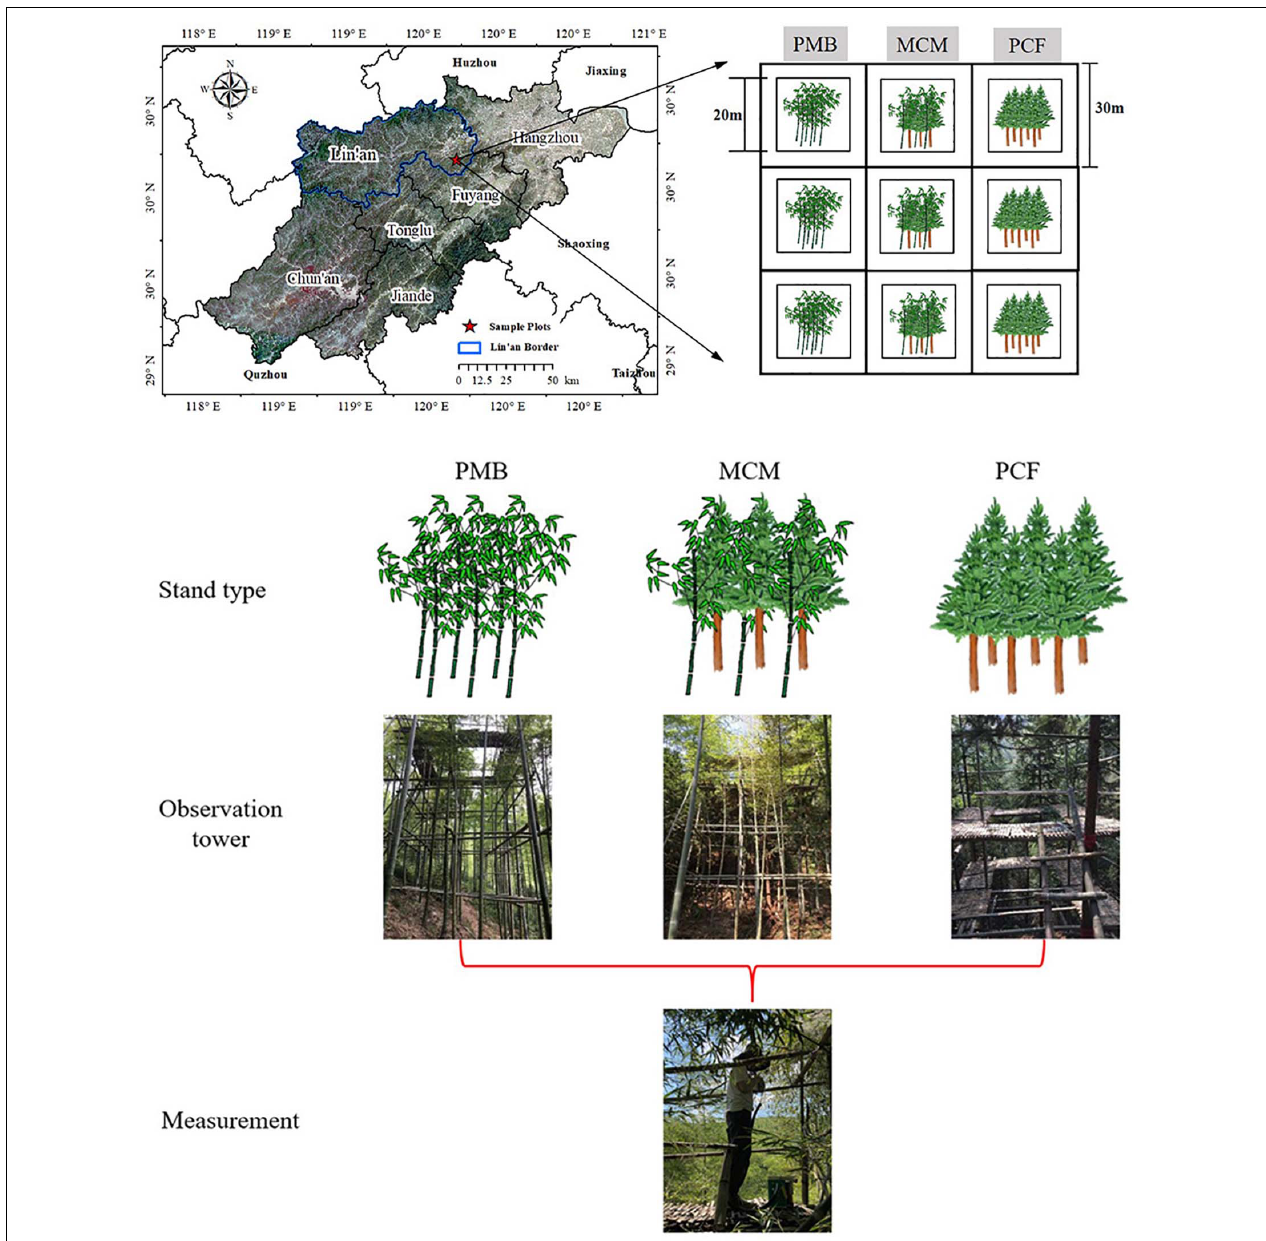
FIGURE 1 | Location of the sample site and sampling design. The white area indicates a buffer; 20 m refers to the length of the border around the plots. See section “Materials and methods” for details.